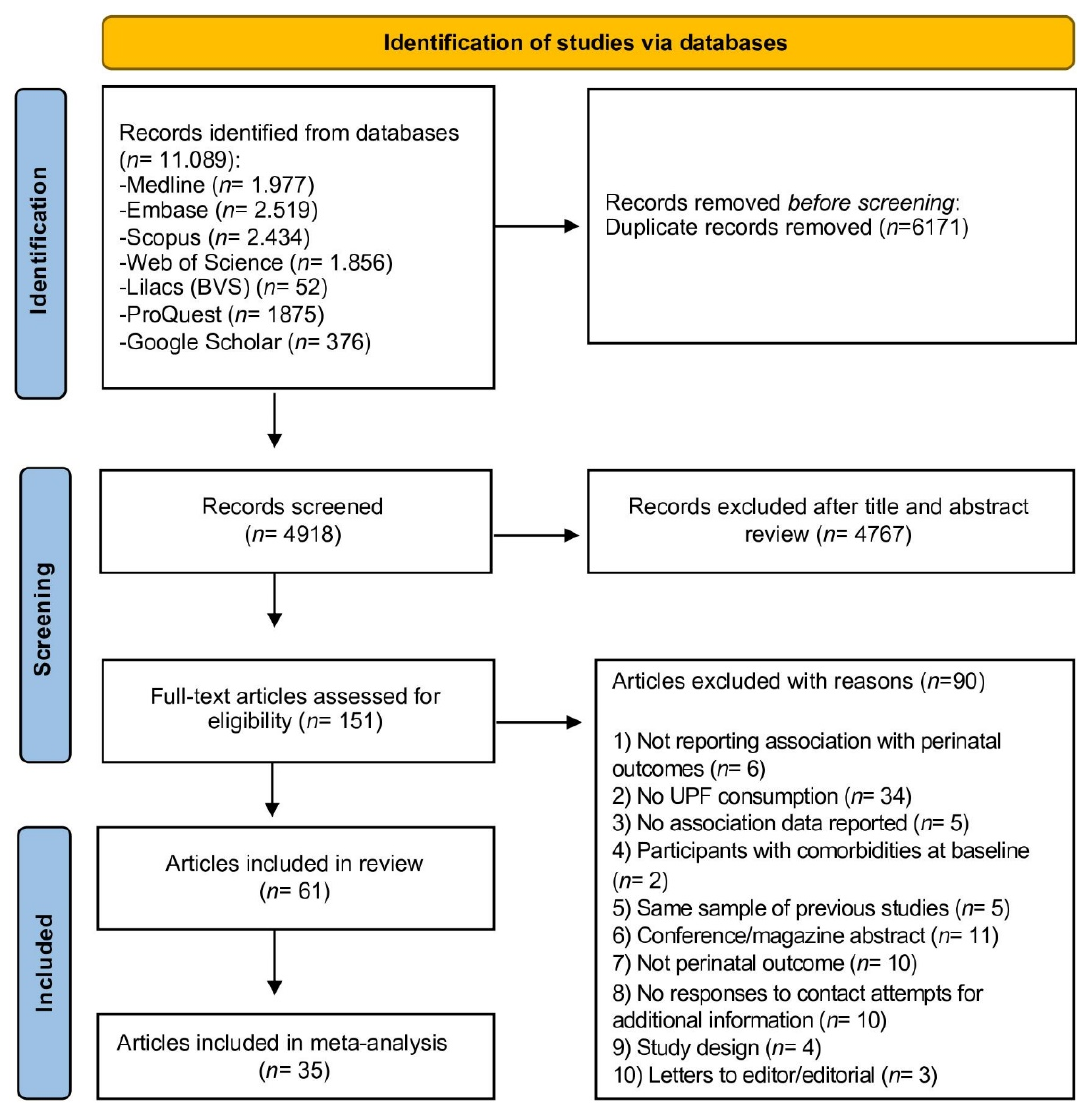
Figure 1. Flowchart of the study selection process. Adapted from PRISMA.